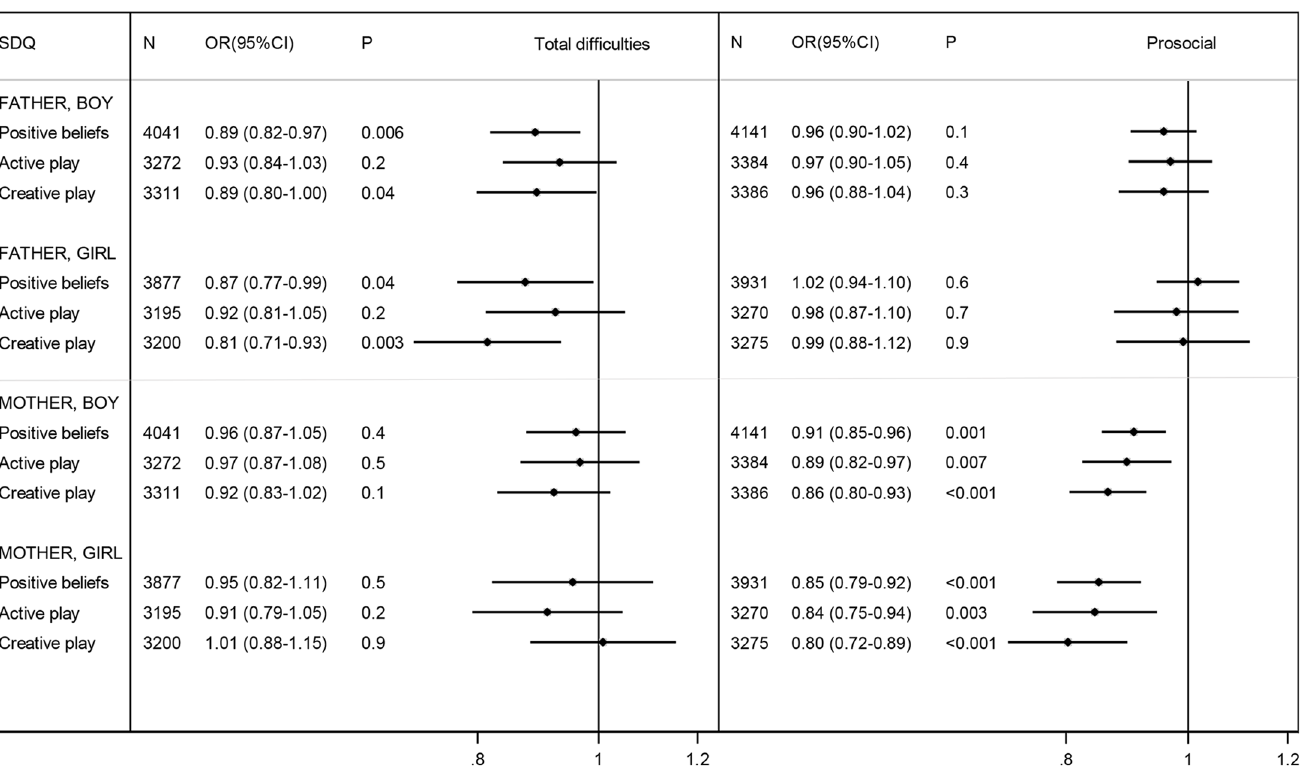
Fig 4. Adjusted odds ratio for child behaviour problems per quintile of involvement: both-parent measures. Positive parenting beliefs at 9 months, active/creative play at 5 years (see Table 2 for details). Behaviour problems respectively at 5, 7 years: SDQ score in the top decile for the total difficulties scale, or bottom decile for the prosocial scale. See Table 3 for adjustment